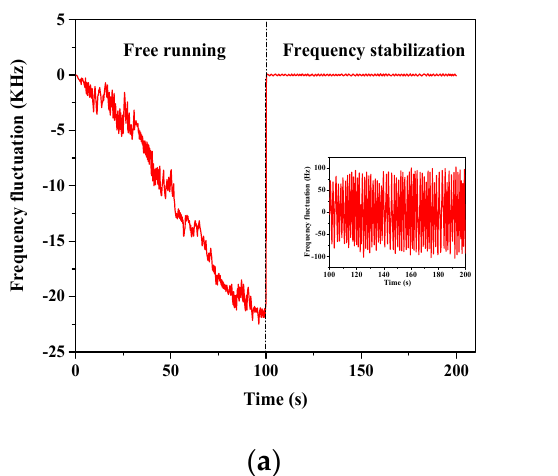
and frequency stabilization case; ( b ) long-term frequency fluctuation.